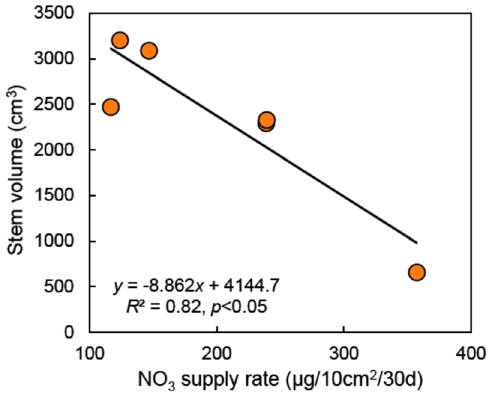
Figure 6. Negative relationship between soil NO 3 supply rate and stem volume growth after five growing seasons for white pine in the black plastic mulch treatment ( n = 6). The solid line represents a linear least-square regression.